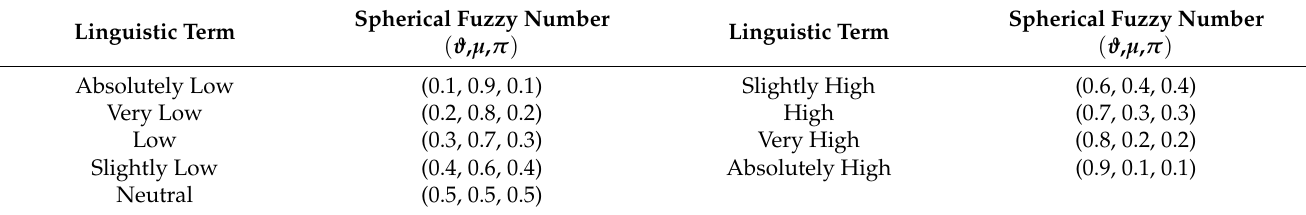
Table 4. Linguistic terms for decision matrix